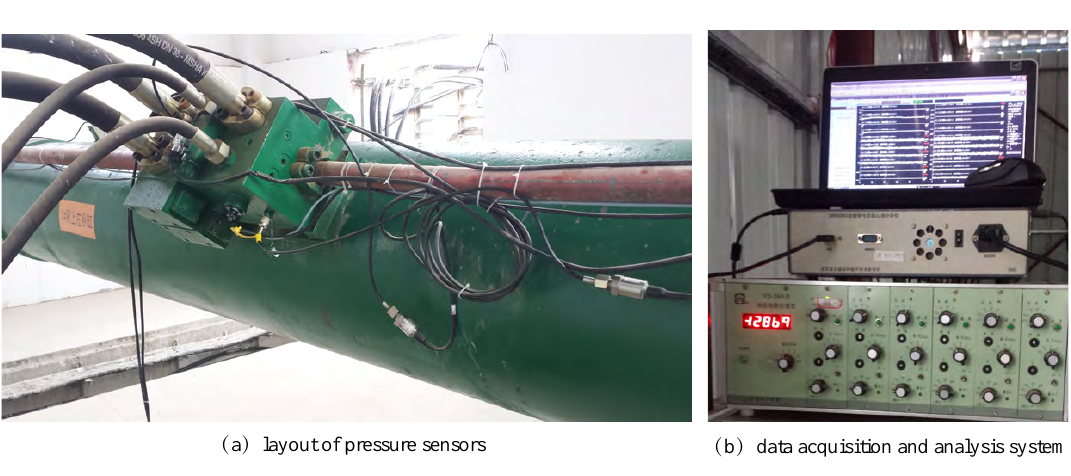
Figure 3. The layouts of pressure sensors, the data acquisition and analysis system. Table 1. The parameters of operating the machinery of miter gates.